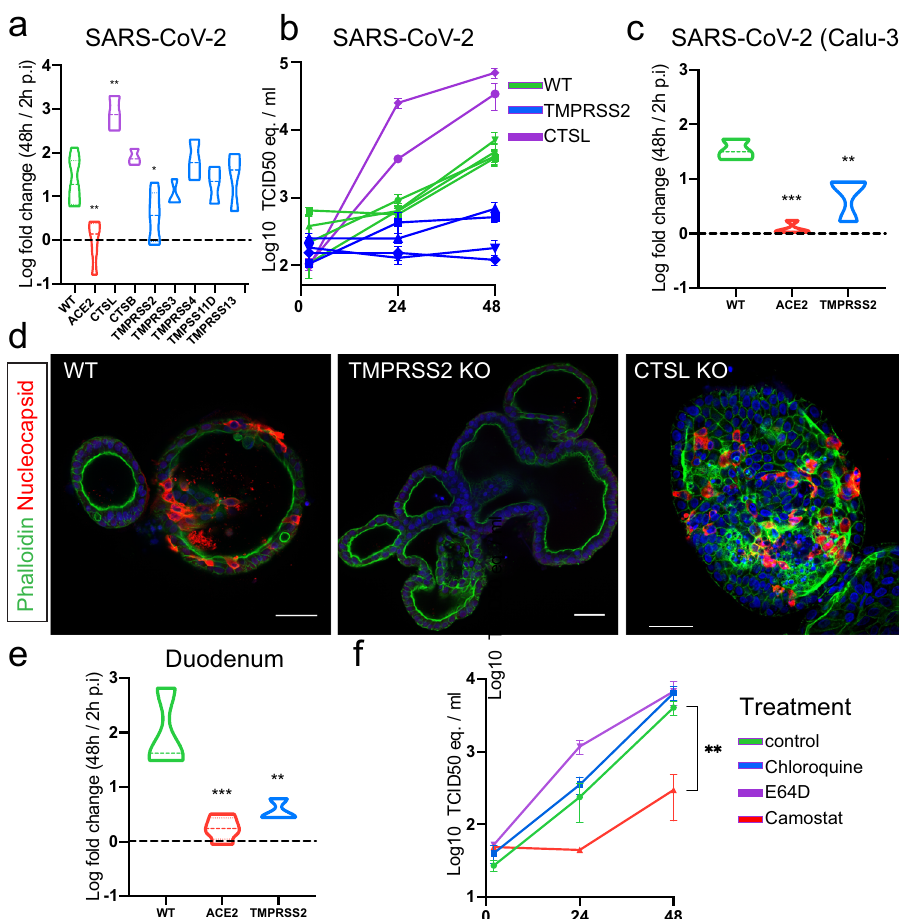
Fig. 4 Loss-of-function screen of host proteases reveals essential role for TMPRSS2 but not Cathepsins in viral replication. a Violin plot displaying the Log10 ratio between the viral titer at 48 h compared to 2 h post infection (p.i.) quanti fi ed by qPCR targeting the E gene. The dotted line indicates a fold change of 1. Dotted lines within the violins indicate the median and quartiles. Data from replication curves in Fig. 3a, c is included. N = 7 for WT, N = 6 for TMPRSS2, N = 5 for ACE2, and N = 3 for the remaining genes. Exact p values can be found in Supplementary dataset 5. b qPCR analysis targeting the E gene to quantify viral replication of wildtype organoids and cells harboring a loss-of-function of a single host factor. Error bars represent SEM. Each data point represents the mean of 3 replicates. c Violin plot displaying the Log10 ratio between the viral titer at 48 h compared to 2 h post infection (p.i.) quanti fi ed by qPCR targeting the E gene in organoids infected with SARS-CoV-2 propagated on Calu-3 cells. The dotted line indicates a fold change of 1. Dotted lines within the violins indicate the median and quartiles. N = 3 for WT, N = 4 for ACE2 and N = 3 for TMPRSS2. Exact p values can be found in Supplementary dataset 5. d Immuno fl uorescent staining of SARS-CoV-2 infected WT and CTSL and TMPRSS2 KO organoids. Virus is visualized by nucleocapsid protein. TMPRSS2 KO organoids do not facilitate viral infection, although very rare, infected cells can be observed. CTSL KO organoids display abundant viral infection. Scale bars are 50 µ m. Experiment was repeated 2 times with similar results. e Violin plot displaying the Log10 ratio between the viral titer at 48 h compared to 2 h post infection (p.i.) quanti fi ed by qPCR targeting the E gene in organoids of the human duodenum. The dotted line indicates a fold change of 1. Dotted lines within the violins indicate the median and quartiles. N = 3 for WT, N = 5 for ACE2 and N = 3 for TMPRSS2. Exact p values can be found in Supplementary dataset 5. f qPCR analysis targeting the E gene to quantify viral replication of organoids treated with the serine protease inhibitor Camostat, chloroquine or cysteine protease inhibitor E64D. Error bars represent SEM. Each data point represents the mean of 3 replicates. Statistics were performed by one-way ANOVA followed by a multiple-comparison test (Original FDR method of Benjamini and Hochberg; Q = 0.05) on log10 transformed values in ( a ), ( c ), ( e ) and timepoint 48 h of ( f ). * P < 0.05; ** P < 0.01; *** P < 0.001; **** P < 0.0001. Exact p values can be found in Supplementary dataset